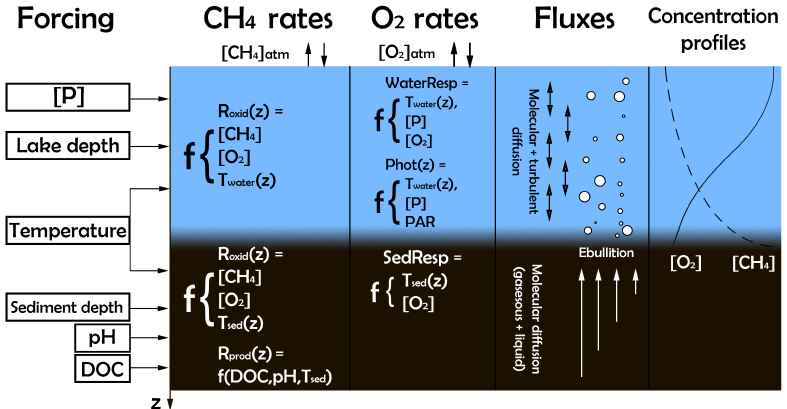
Figure 2. Schematic representation of the model structure. The one-dimensional column is divided into lake water and sediments. The forcing consists of lake and sediment depths, the water T water (z) and sediment T sed (z) temperature, DOC and phosphorous concentration [P], and pH. CH 4 production occurs only in the sediments. The methane production rate R prod (z) is a function of the sediment temperature; the DOC, which is taken as a measure for substrate availability; and pH. CH 4 oxidation is calculated in the different way for sediments and for lake water. The CH 4 oxidation rate R oxid (z) follows Michaelis–Menten kinetics for both methane and oxygen and is a function of the water and sediment temperature. The water respiration rate WaterResp (z) is a function of the water temperature and the phosphorous concentration, which is taken as a measure for abundance of phytoplankton. The aquatic photosynthesis rate Phot (z) is a function of water temperature, photosynthetic active radiation and phosphorous concentration, which is used as a substitution for chlorophyll a concentration through an empirical function. The sediment respiration rate SedResp (z) is a function of the sediment temperature. Both water and sediment respiration follow Michaelis–Menten kinetics for oxygen uptake. Transport of CH 4 in lake sediments proceeds by (1) molecular diffusion through gas- filled and water-filled pores and (2) ebullition, which is the formation of gas bubbles in the sediment layer and their immediate ascent to the water surface. Transport of CH 4 in lake water proceeds by (1) wind-induced turbulent diffusion and (2) molecular diffusion in water. Transport of O 2 is the same except for ebullition. The model calculates methane fluxes to the atmosphere and CH 4 and O 2 concentration profiles in the lake water and